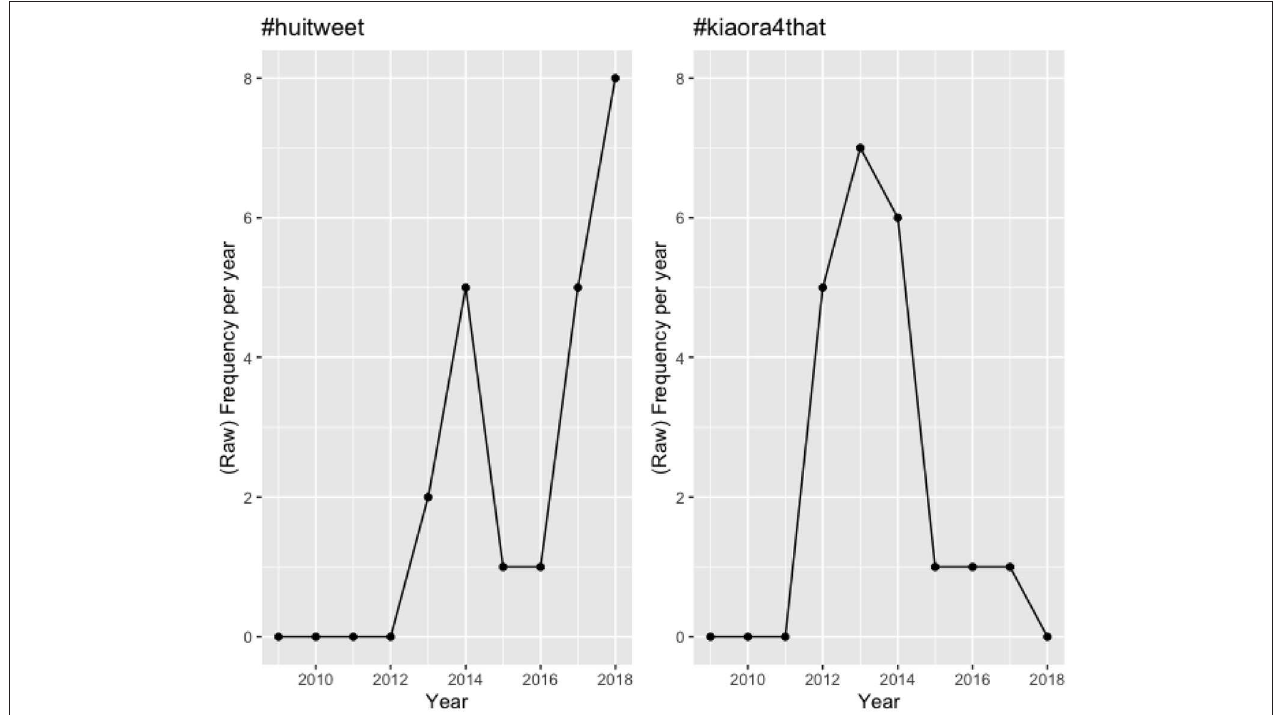
FIGURE 6 | Diachronic trend for #huitweet and #kiaora4that in the HH sub-corpus.